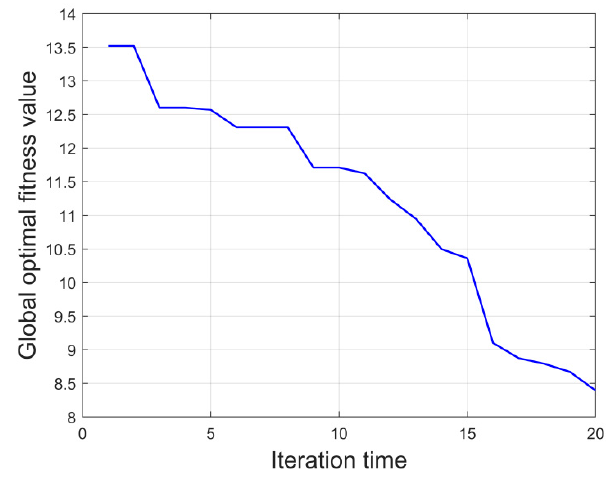
Figure 11. Convergence curve of FOPID control system.